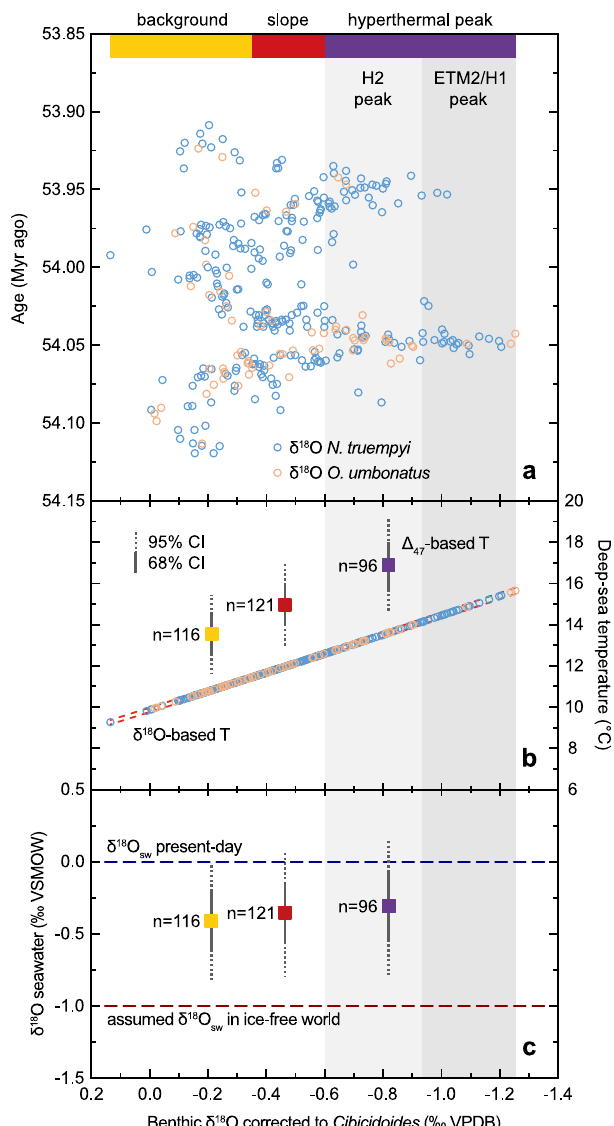
Fig. 2 Deep-sea temperatures and δ 18 O seawater composition across ETM2 – H2. a δ 18 O b values derived from N. truempyi and O. umbonatus that are corrected towards Cibicidoides (assumed seawater equilibrium). b Deep-sea temperatures based on Δ 47 and δ 18 O b including the number of Δ 47 (and δ 18 O b ) measurements that are contained in the background, slope, and hyperthermal peak temperature bins. The yellow (background), red (slope), and purple (hyperthermal peak) bars indicate the range in δ 18 O b values corresponding to the Δ 47 measurements that were used for compiling the three bins. The dark grey error bars on the Δ 47 -based temperatures represent fully propagated analytical and calibration uncertainties as 68% (solid) and 95% (dashed) CI (Methods). The dashed red envelope on the δ 18 O b -based deep-sea temperatures displays the uncertainty (95% CI) of the δ 18 O b - temperature calibration of Marchitto et al. 77 . Analytical uncertainty on the δ 18 O b -based temperatures of the three bins is very small (±0.1°C 95% CI) and is therefore contained within the data symbols (Methods). c δ 18 O sw (in ‰ VSMOW) of the background, slope, and hyperthermal peak bins including uncertainties as 68% (solid) and 95% (dashed) CI. Values of δ 18 O sw were calculated using the mean Δ 47 -based temperatures in combination with the average δ 18 O b values of the three bins in the δ 18 O b -temperature relationship of Marchitto et al. 77 (Methods). The horizontal red and blue dashed lines show the assumed δ 18 O sw value based on ice-free conditions and the present- day δ 18 O sw value,